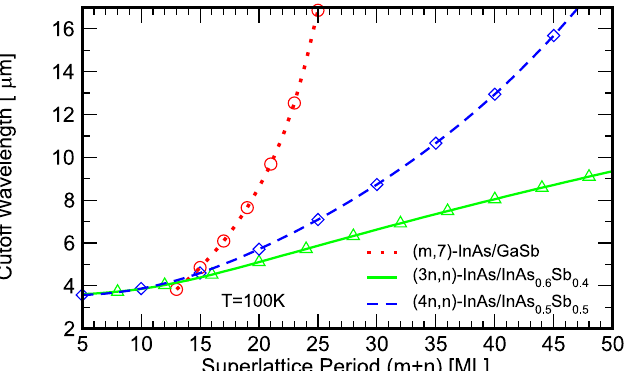
Figure 7. Calculated cutoff wavelength for the sets of ( m ,7)-InAs/GaSb, (3 n , n )-InAs/InAs 0.6 Sb 0.4 , and (4 n , n )-InAs/InAs 0.5 Sb 0.5 superlattices, as functions of the superlattice period in monolayers (MLs).